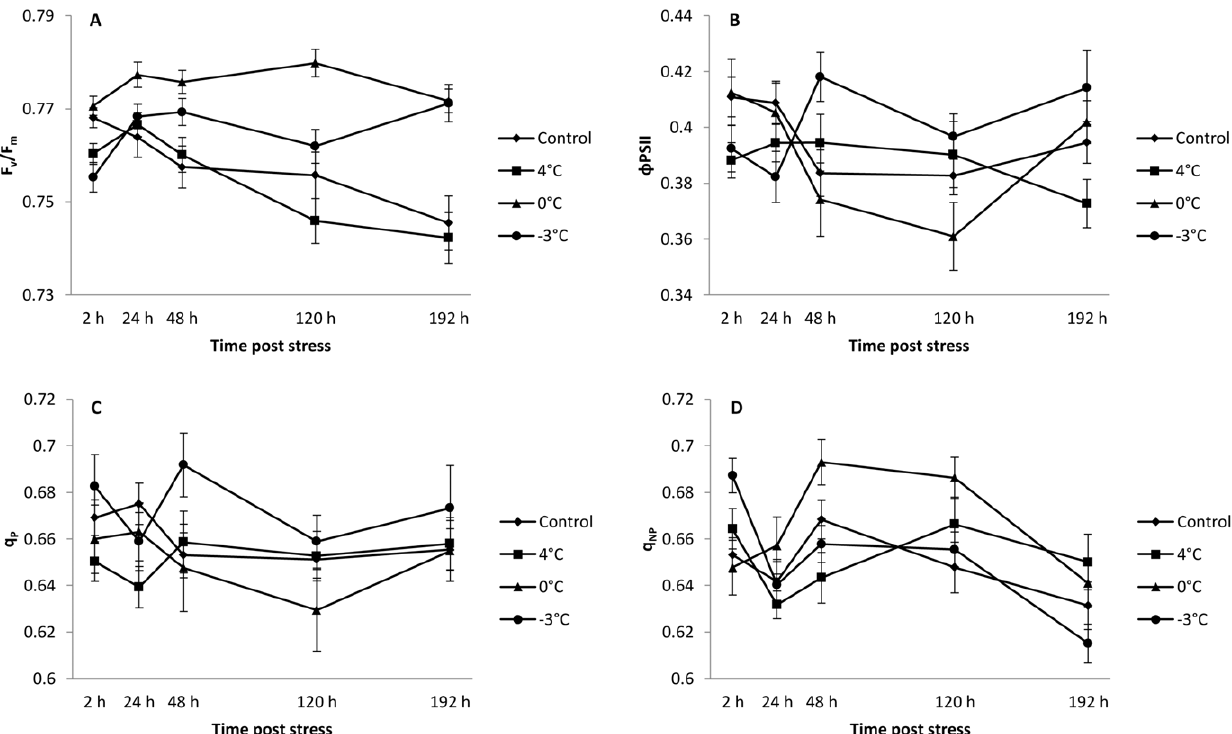
Figure 3. Changes in (A) maximum efficiency of PSII photochemistry after dark adaptation (F v /F m ), (B) effective PSII quantum yield ( W PSII), (C) photochemical quenching (q P ) and (D) non-photochemical quenching (q NP ) in control and 4 6 C, 0 6 C or 2 3 6 C-treated stalks. Measurements were performed 2, 24, 48, 120 and 192 h after cold treatment. Values are means 6 standard errors (n=45).